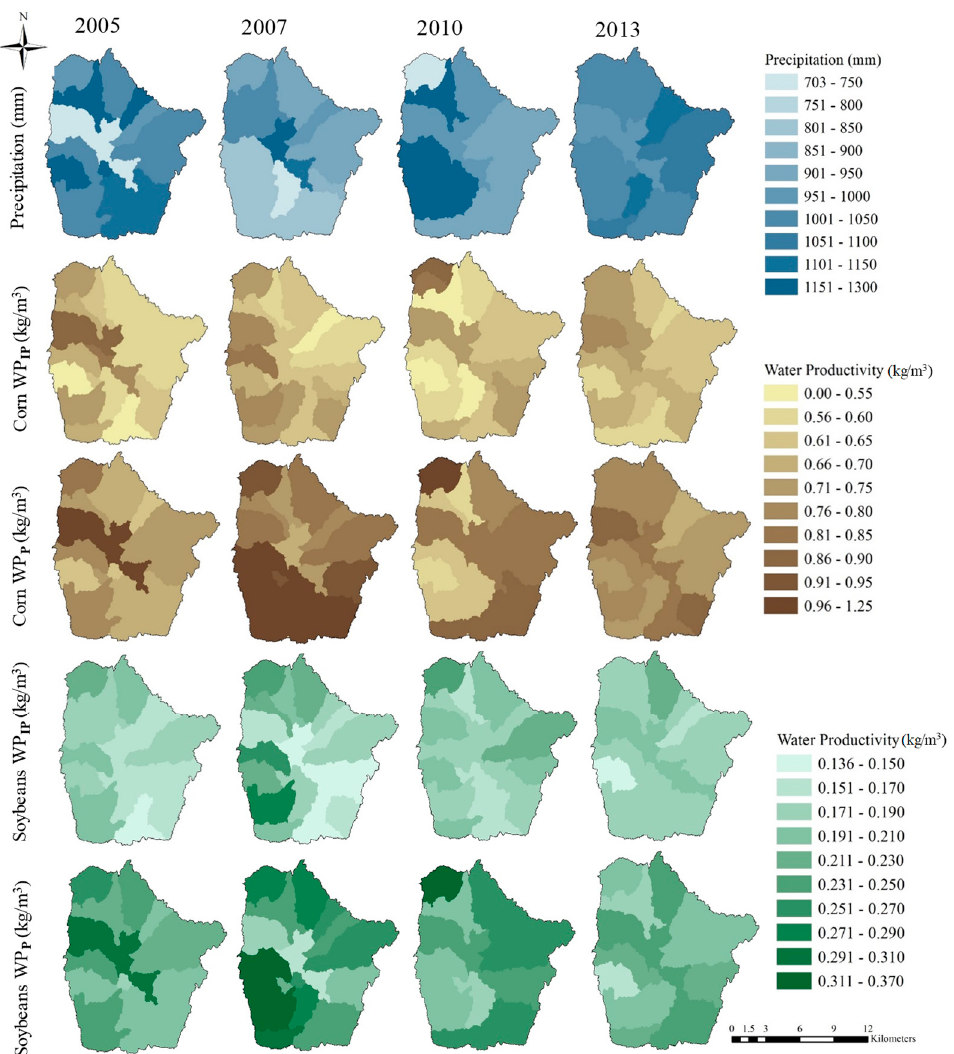
Figure 7. Spatial variability of the total ( WP IP ) and green water productivity ( WP P ) for both corn and soybean for four dry years: 2005, 2007, 2010, and 2013.